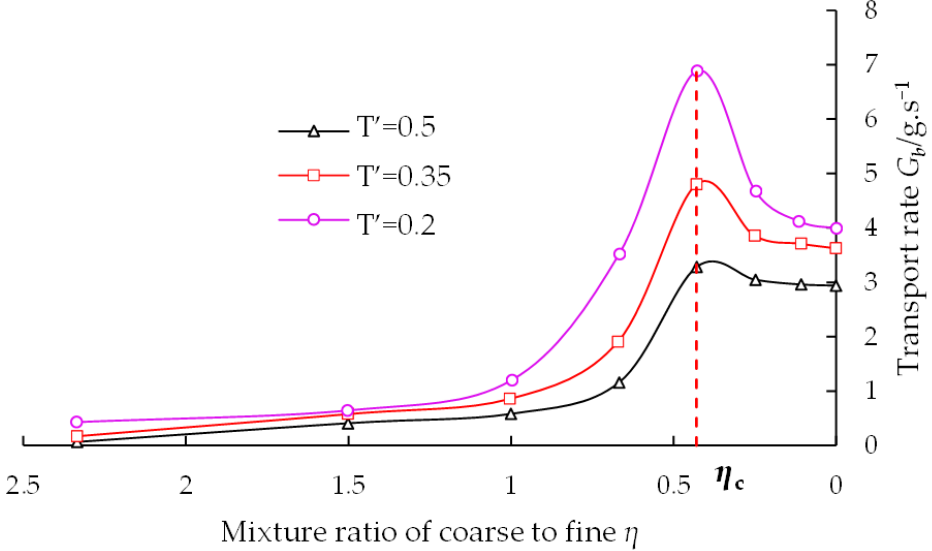
Figure 11. Association between transport rates G b and mixture ratios η at the same time ( Q = 0.026 m 3 /s, F r = 0.85). The changes in the instant bed load transport rates with the mixture ratio at different moments are almost similar and generally present a humped curve.